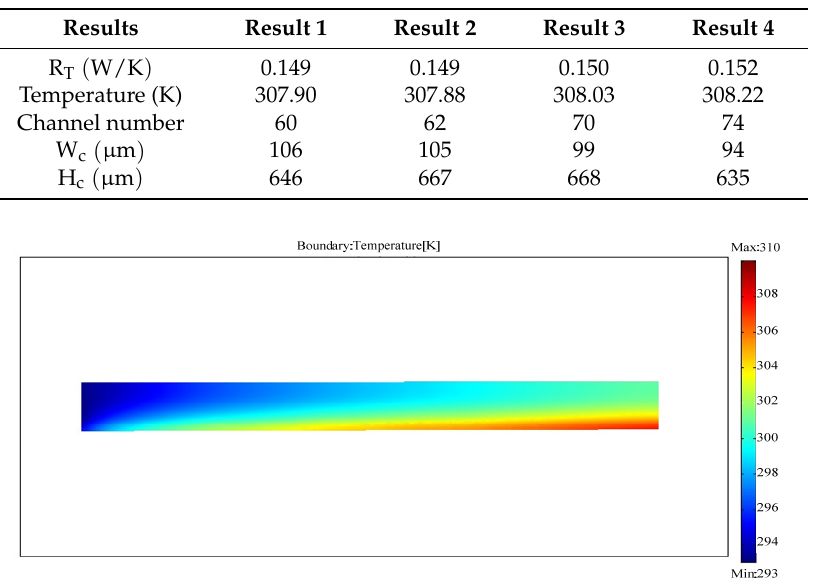
Figure 9. The optimal result of the micro multi ‐ channel heat sink in Case 1 with a channel number of 60.